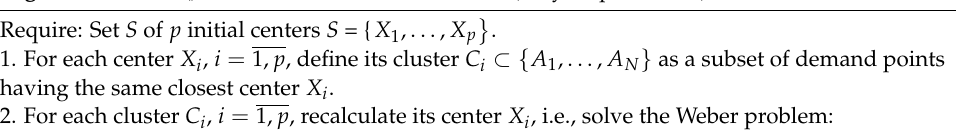
Algorithm 1 ALA (): Alternate Location-Allocation (Lloyd’s